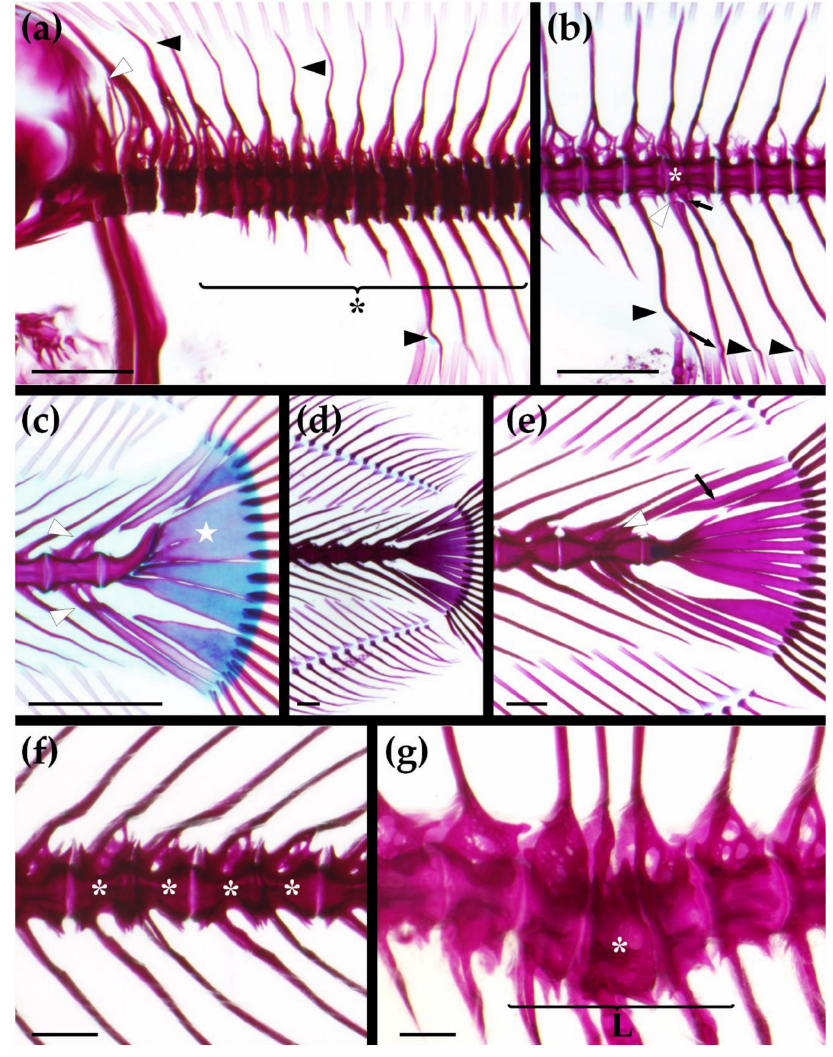
Figure 2. More common anomalies in 31 days after hatching (dah) ( a – c ) and 105 dah ( d – g ) Senegalese sole ( Solea senegalensis ). Double staining technique with alcian blue and alizarin red. ( a ) Severe deformations affecting both abdominal and caudal vertebrae exhibiting evident flattening of centra and irregularity of vertebral surface and central fusion among the affected elements (asterisk); slight deformities in abdominal neural spines and first caudal haemal spine (black arrowheads); note also the two short neural spines with absence of the neural arch of the first abdominal vertebra (white arrowhead); ( b ) Fusion between the second and third caudal vertebrae with shortening of the first vertebral body (asterisk); incomplete arch (white arrowhead) and alteration of the insertion (short arrow) of the caudal haemal arches; twisted haemal spines (black arrowheads), with a thin layer of bone and slight torsion at the tip of the haemal spine (black arrow); ( c ) Fusion between preurals with fusion of neural and haemal arches (white arrowheads), the union has the appearance of one elongated vertebra; alterations of the shape of epural and hypural 5; fusion among hypurals (white star); ( d ) Overview of the caudal complex in 105 dah Senegalese sole; ( e ) Vertebral fusion between preurals and the last caudal centra, displaying also fusion of preural neural arches (white arrowhead); deformities of hypural 5 and parhypural, denote the thin layer of bony tissue in epural reshaping the element (black arrow); ( f ) Fusions among caudal vertebrae exhibiting an altered orientation of the central structure in opposite directions (asterisks); ( g ) Lordosis in the transition area between abdominal and caudal regions (L); the affected vertebrae are also shorter and deformed, highlights the central vertebra which shows a trapezoidal shape (asterisk). Bars = 500 µ